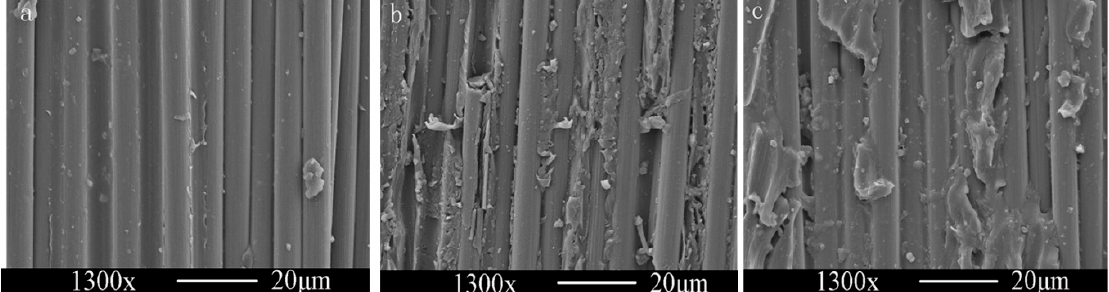
Figure 7. Fractured SEM images of CF/epoxy (EP) composite ( a ) desized CF; ( b ) CNT deposited CF without ultrasonication; ( c ) CNTs deposited CF with ultrasonication.